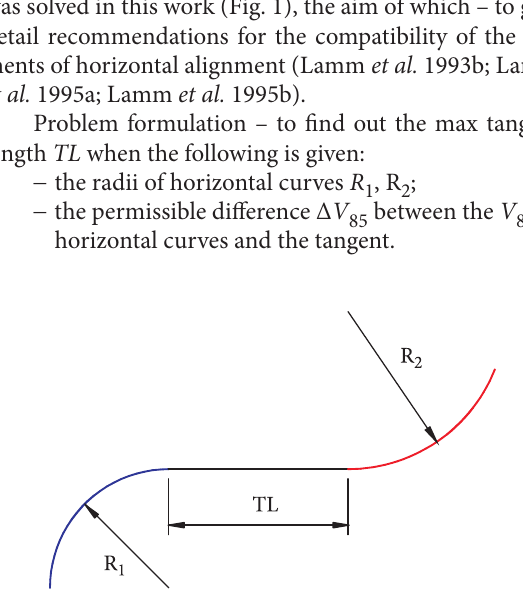
Fig. 1. Th e scheme for solving the problem of compatibility between the elements of horizontal